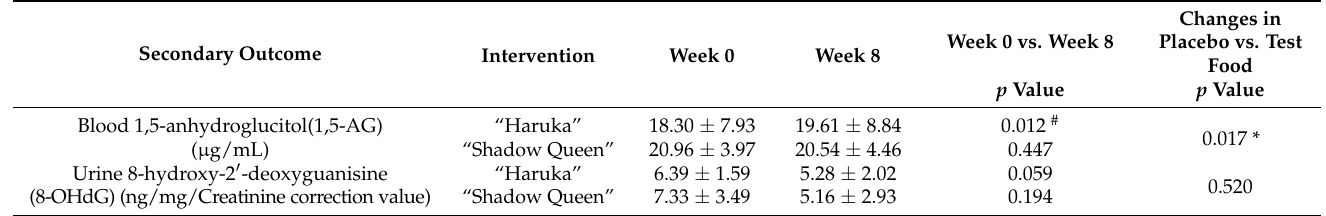
Table 5. Changes in the secondary outcome after taking “Shadow Queen” and